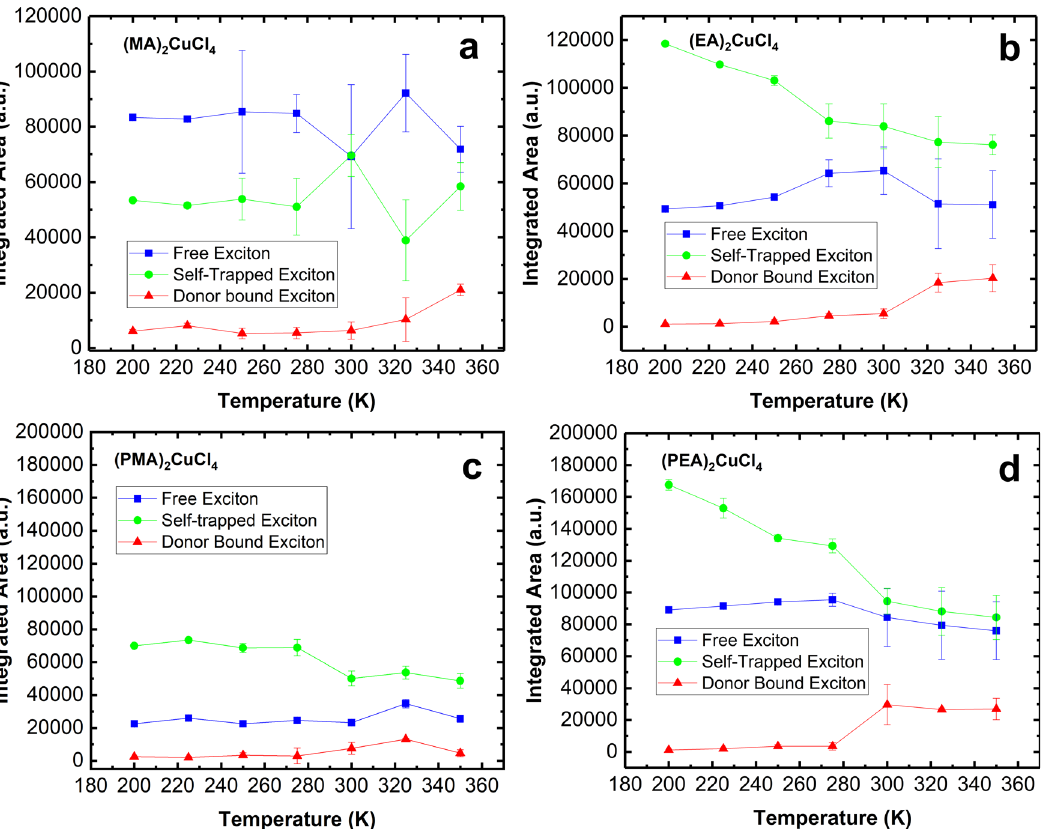
Fig. 5 The overview of integrated area acquired from the PL spectra of A 2 CuCl 4 compounds. (MA) 2 CuCl 4 ( a ), (EA) 2 CuCl 4 ( b ), (PMA) 2 CuCl 4 ( c ), and (PEA) 2 CuCl 4 ( d ), respectively. Self-trapped exciton (green circles), free exciton (blue squares), and donor bound exciton (red triangles). Error bars are collected from the respective fi tting